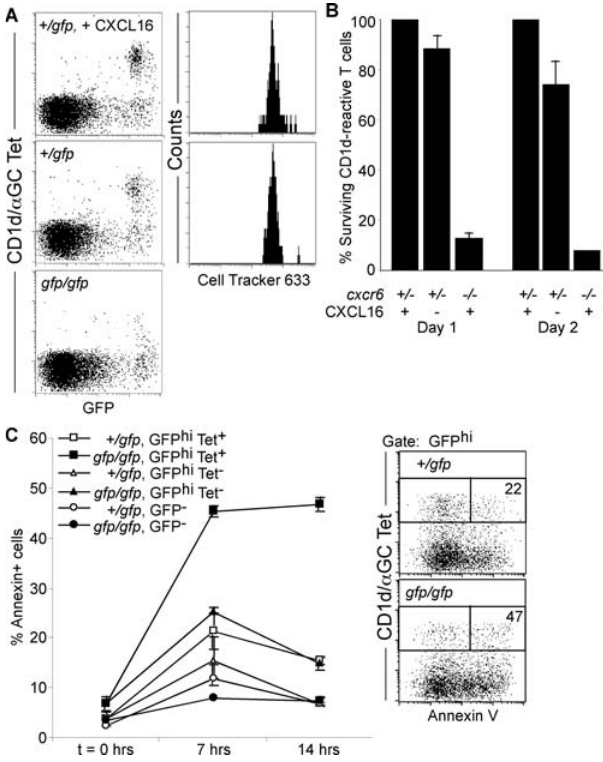
Figure 5. Requirement for CXCR6 in Survival of CD1d-Reactive T Cells (A) Flow cytometry analysis of liver leukocytes from GFP knock-in mice after overnight culture. Dot plots represent GFP signal versus CD1d- a -GalCer-tetramer staining. Histogram plots represent Cell Tracker 633 labeling gated on tetramer-positive cells, indicating no cell division during the course of the culture. (B) Survival of liver NKT cells from cxcr6 gfp/ þ and cxcr6 gfp/gfp mice. Duplicate samples of 5 3 10 4 CD1d-reactive T cells/well were incubated for each condition and time point. Histograms represent the percentage of viable, CD1d- a -GalCer-tetramer-positive GFP hi cells, as determined by flow cytometry at the indicated time points. The proportion of CXCL16-cultured cells from control cxcr6 gfp/ þ mice was set at 100%. Values are mean 6 standard deviation from three independent experiments. (C) Flow cytometry analysis of liver leukocyte apoptosis in culture. The percentage of cells binding Annexin V was determined by flow cytometry at the indicated time points. Results are representative of two independent experiments. A representative analysis at 10 h is shown on the right, with the percentage of CD1- a GC-tetramer- positive and Annexin V–positive cells indicated. DOI: